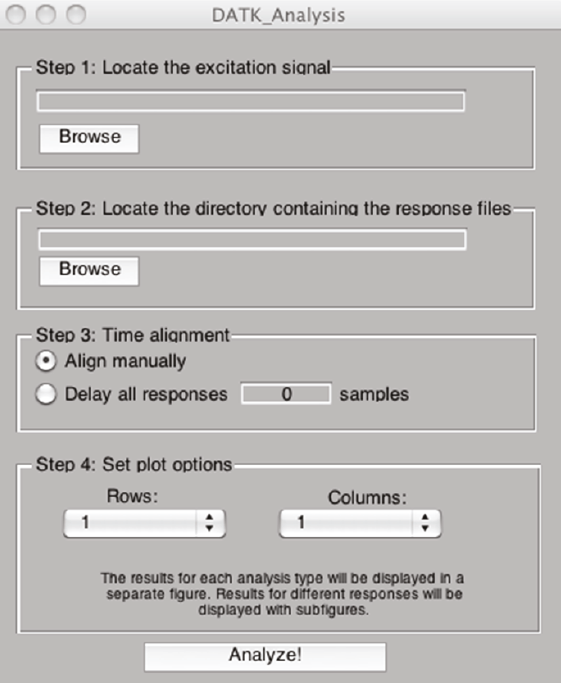
(in seconds), and the SPL parameter is the estimated F - weighted sound pressure level at which the distorted sine signal would be